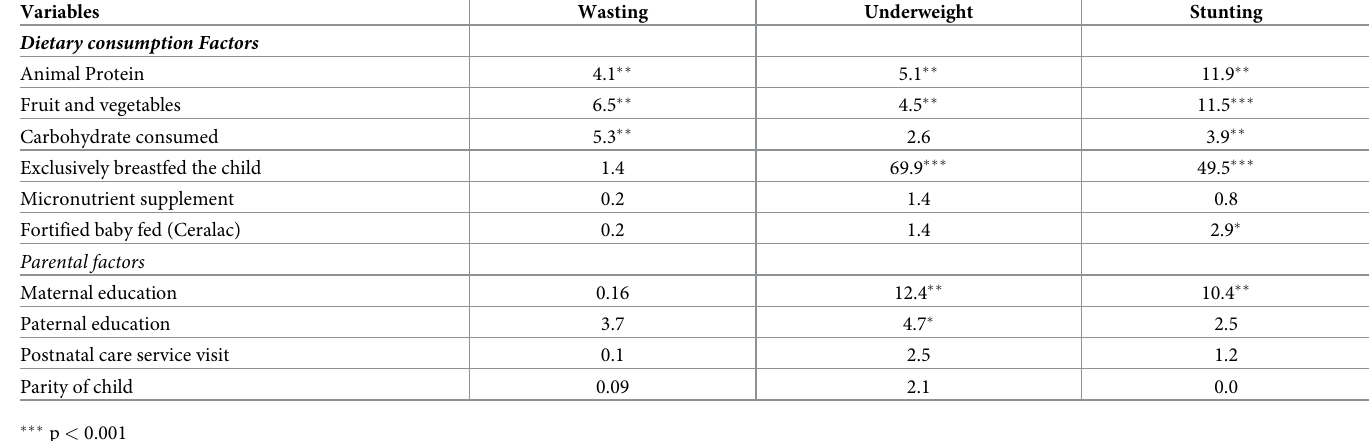
Table 2. Pearson’s Chi-square results of the measure of association between explanatory variables and nutrition outcome, namely, wasting, underweight and stunt- ing among rural